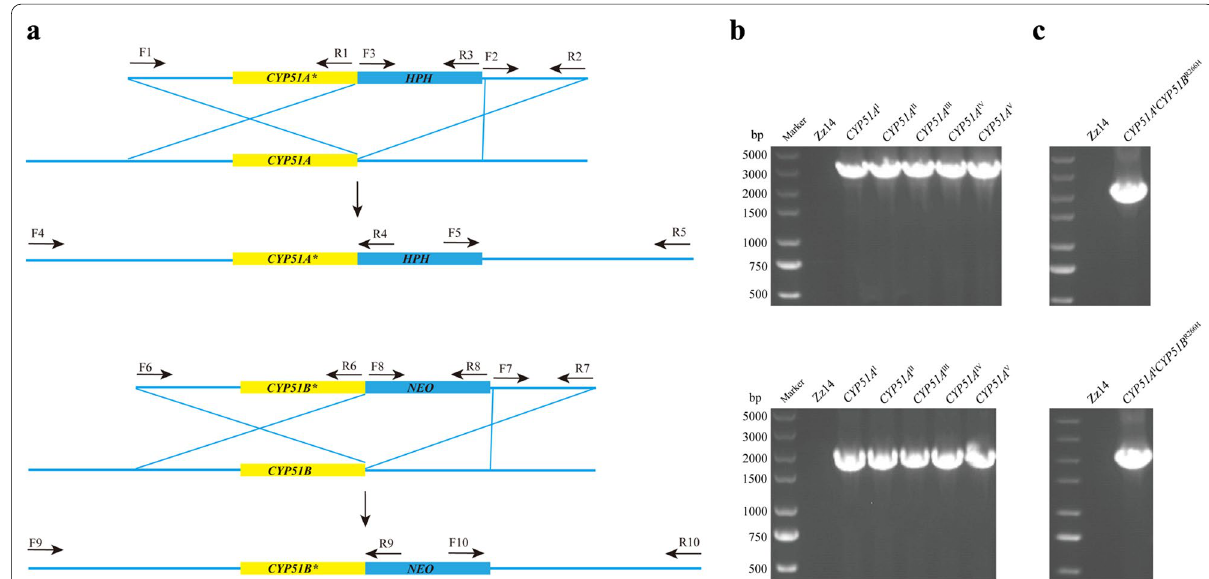
Fig. 7 Construction and identification of CYP51A or CYP51B replacement mutants of Colletotrichum siamense . a Strategies for the construction of CYP51A or CYP51B replacement mutants. The CYP51A and CYP51B replacement vectors contain the hygromycin phosphotransferase gene ( HPH ) and geneticin resistance gene ( NEO ), respectively. The primers used are indicated by arrows, and asterisks indicate the mutations in CYP51A and CYP51B . b PCR identification of the CYP51A replacement mutants. Fragments of 2.97 kb and 1.87 kb could be amplified from the CYP51A replacement mutants with the primer pair F4/R4 and F5/R5, respectively, but could not be amplified from the sensitive isolates. c PCR identification of the CYP51B replacement mutants. Fragments of 2.09 kb and 1.95 kb could be amplified from the CYP51B replacement mutants with the primer pair F10/R10 and F11/R11, respectively, but could not be amplified from the sensitive isolates